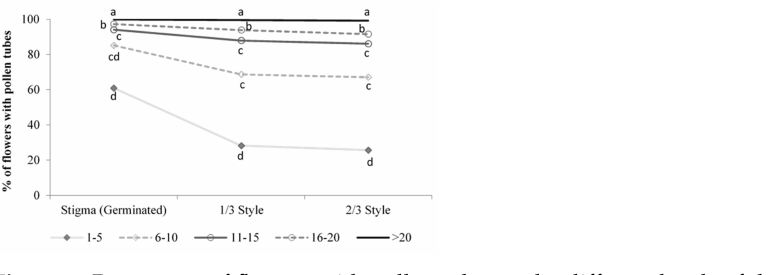
Figure 6. Percentage of flowers with pollen tubes at the different levels of the style in relation to the pollen load size on the avocado stigma. Different letters indicate significant differences between groups at p < 0.05 (GLM analysis followed by Tukey HSD